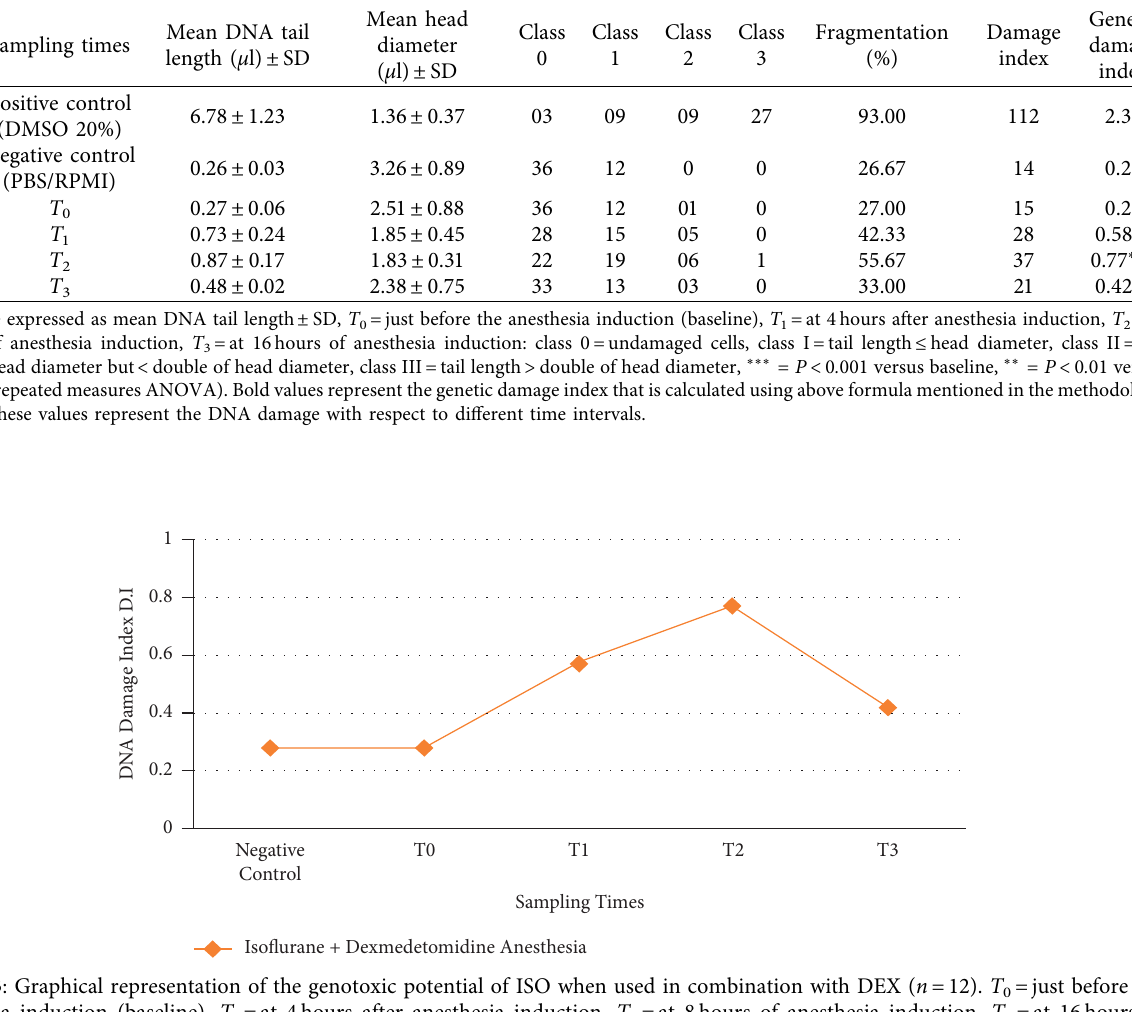
� just before the 0